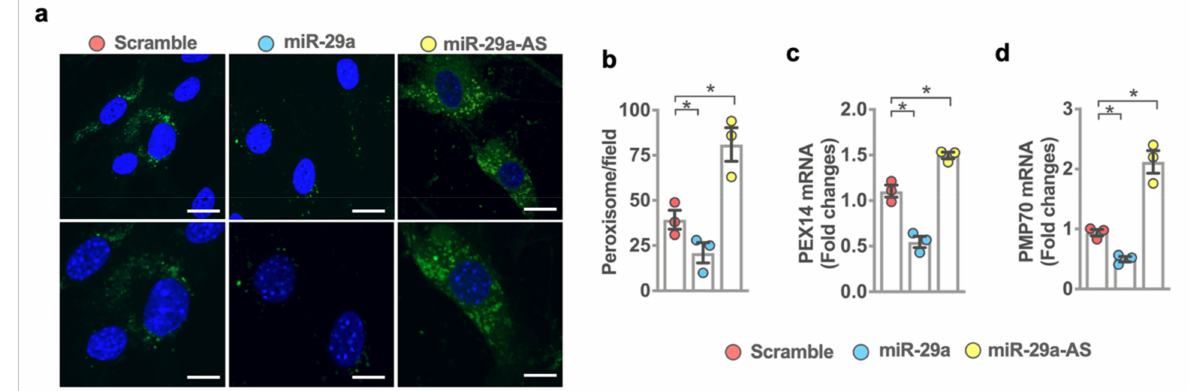
Figure 6. Analysis of peroxisome biogenesis in miR-29a mimic or antisense oligonucleotide-treated bone marrow mes- enchymal stem cells during adipogenic differentiation. Images of Pmp70 immunofluorescence-labeled peroxisomes ( a ); scale bar, 25 µ m (upper panel); 10 µ m (lower panel). Forced miR-29a expression reduced peroxisomal granule formation ( b ), Pex14 ( c ), and Pmp70 ( d ) expression, whereas miR-29a knockdown promoted peroxisome formation. Mean ± S.E. is calculated from 3 experiments. * p < 0.05 upon ANOVA test and Bonferroni post hoc test. Scramble, scrambled control; miR-29a, miR-29a mimic; miR-29a-AS, miR-29a antisense oligonucleotide.